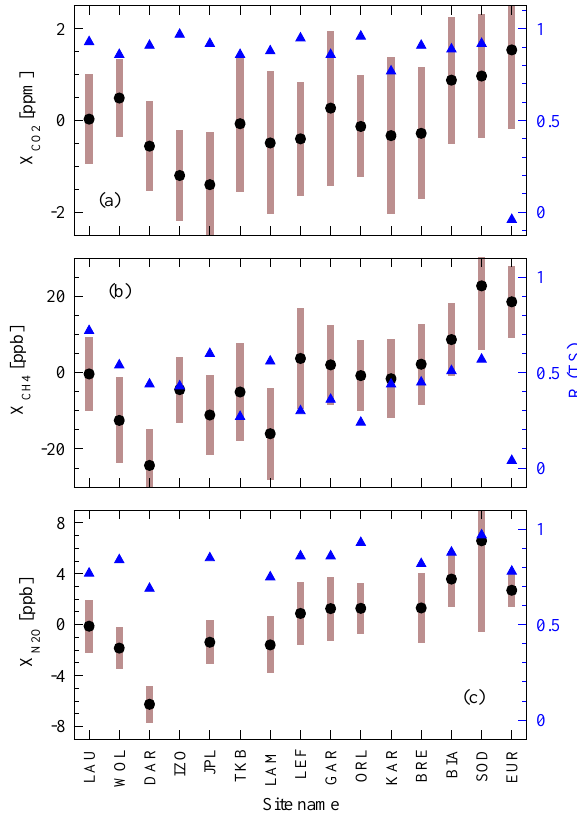
Fig. 5. The model bias b (black dots) and model-data difference d (brown bars) for (a) X CO coefficient R (blue symbols) corresponds to the y-axis on right. No observations are available for X N sruhe. Biases corresponding to four seasons are shown in Fig. S4.